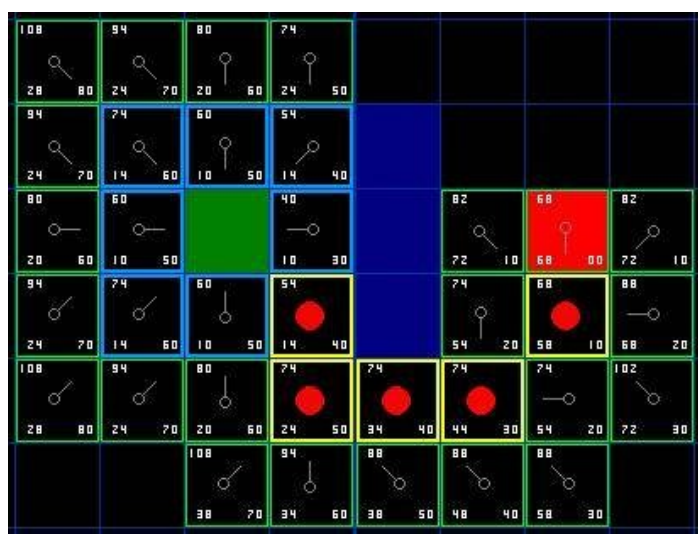
Figure 2. Pathfinding method of the A-star